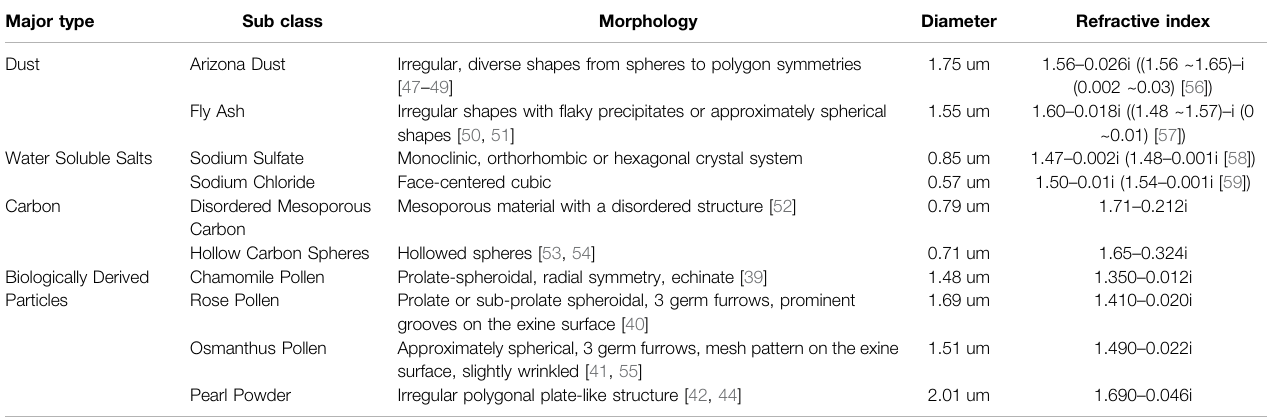
TABLE 1 | Morphology of